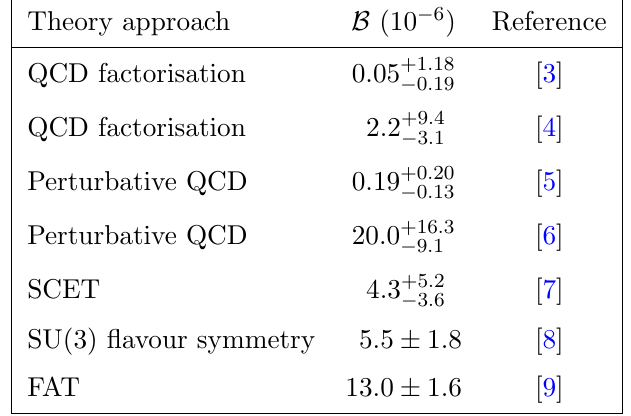
Table 1 . Theoretical predictions for the B 0